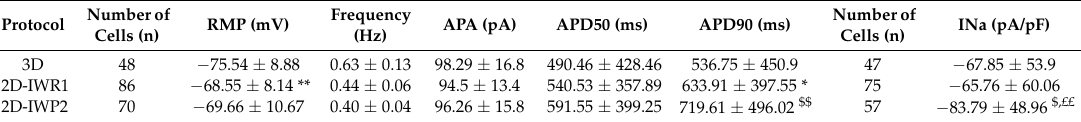
Table 1. Main electrophysiological parameters. (*) indicates significances levels of p < 0.05 and (**) p < 0.01 3D vs. 2D-IWR1. ( $ ) indicates significances levels of p < 0.05 and ( $$ ) p < 0.01 3D